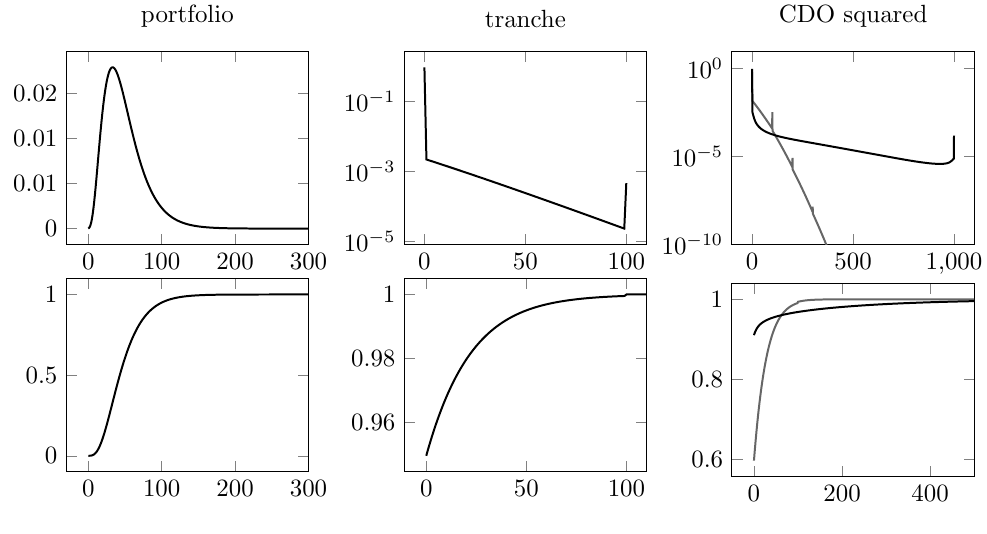
Figure 3: Multi-name credit derivatives losses. The probability (first row) and cumulative (second row) density functions of the loss distribution are displayed for three different derivatives. The first column is concerned with a portfolio of 1000 entities, the second column with a tranche on this portfolio with attachment point 100 and detachment point 200, and the third column with a portfolio of 10 such tranches coming from different portfolios with a unique risk factor (black line) and with independent risk factors (grey